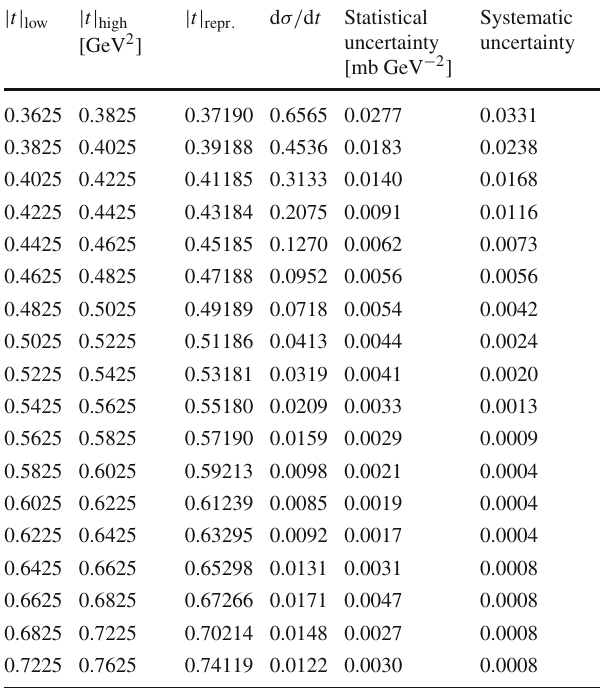
Fig. 9 The differential cross section d σ el / d t at figure shows the dataset DS1 (blue hollow circles) and the dataset DS2 √ s = of the total cross-section measurement (red hollow circles)used for nor- malization [7,21,28]. The nuclear slope B = ( 17 . 1 ± 0 . 3 ) GeV − 2 and the corresponding fit in the | t | -range between 0 . 09 GeV 2 and 0 . 4 GeV 2 is shown. The fit of the diffractive minimum and maximum with a third order polynomial, for two possible functional forms, is presented in the | t | -range between 0.47 and 0.74 GeV 2 and beyond Table 2 The differential cross-section d σ/ d t of DS1 at 2.76 TeV, mea- sured at 13 σ beam